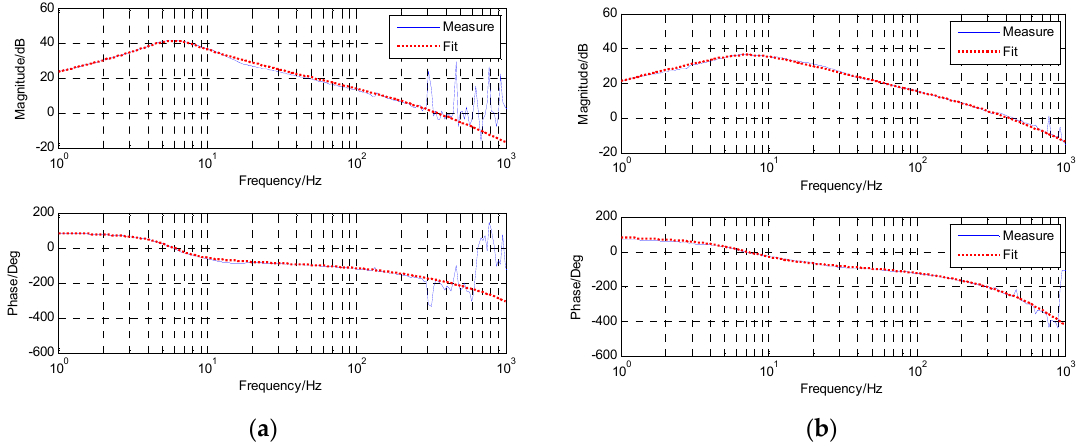
G  based on the FOG; ( b ) F  based v v